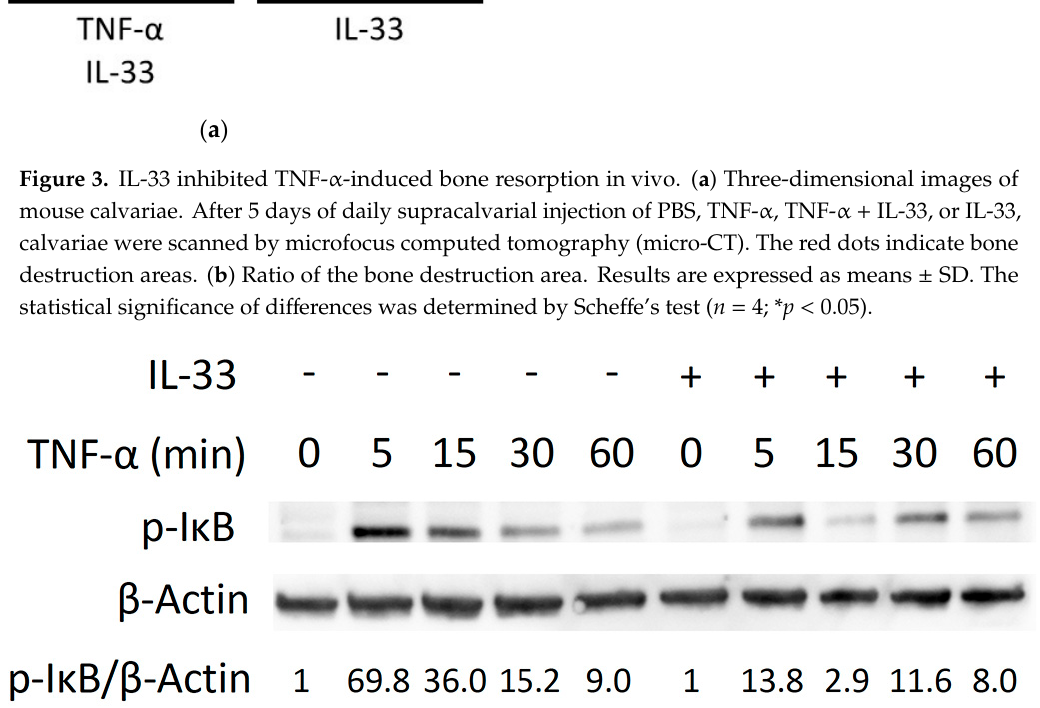
Figure 4. IL-33 inhibits I κ B phosphorylation by TNF- α . Osteoclast precursors were exposed to TNF- α or TNF- α + IL-33 for specific periods. Cells were lysed and contents analyzed by Western blotting.